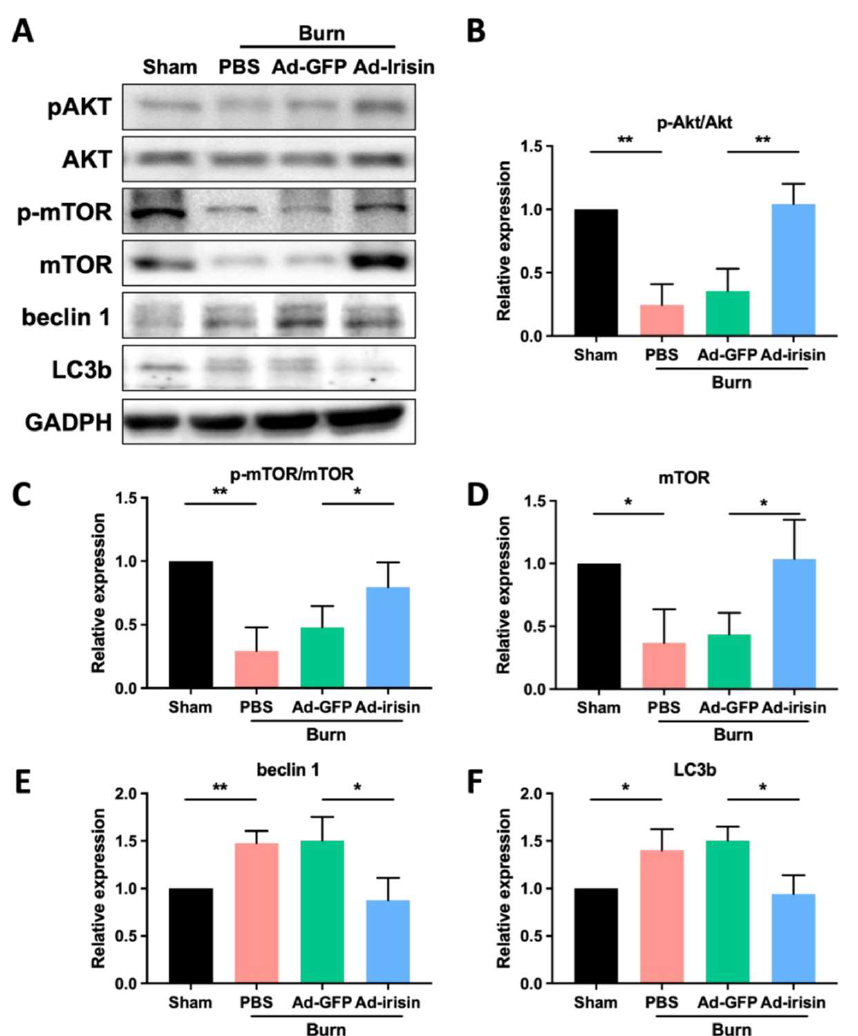
Figure 3. Spinal irisin gene delivery attenuated decreased Akt/mTOR pathway activity. ( A ) Tissue of ipsilateral gastrocnemius muscle in the fourth week after burn injury was subjected to immunoblot- ting analysis. ( B ) Representative bar graph illustrating the normalized p-Akt/Akt expression. Er- ror bars represent standard deviations (SDs). ** p < 0.01, unpaired t -test. ( C ) Representative bar graph illustrating the normalized p-mTOR/mTOR expression. Error bars represent SDs. * p < 0.05, ** p < 0.01, unpaired t -test. ( D – F ) Representative bar graphs illustrating the normalized expression of mTOR, beclin 1, and LC3b, with GAPDH as an internal control. Error bars represent SDs. * p < 0.05, ** p < 0.01, unpaired t